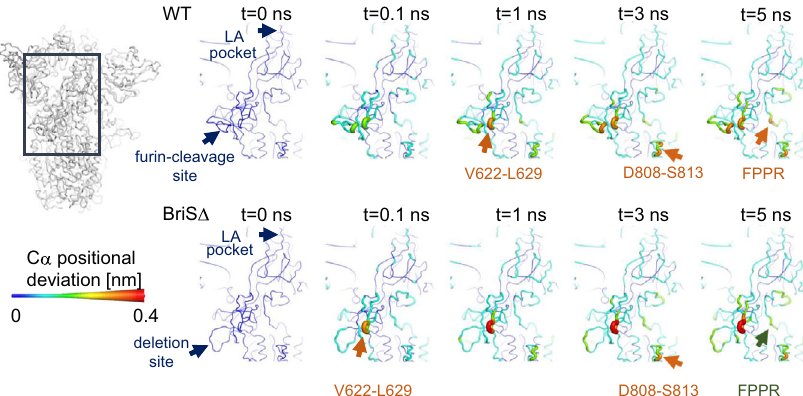
Fig. 5 Dynamical nonequilibrium simulations elucidate impact of LA on S structure. Average C α -positional deviations are shown at 0, 0.1, 1, 3, and 5 ns following LA removal from the FFA-binding pockets of WT S (above) and BriS Δ (below). The C α deviations between the simulations with and without LA were determined for each residue and averaged over the 90 pairs of simulations for each system. The C α average deviations are mapped onto the structure used as the starting point for the LA-bound equilibrium simulations. Both colors and cartoon thickness indicate the average C α -positional deviation values. Important regions of changes